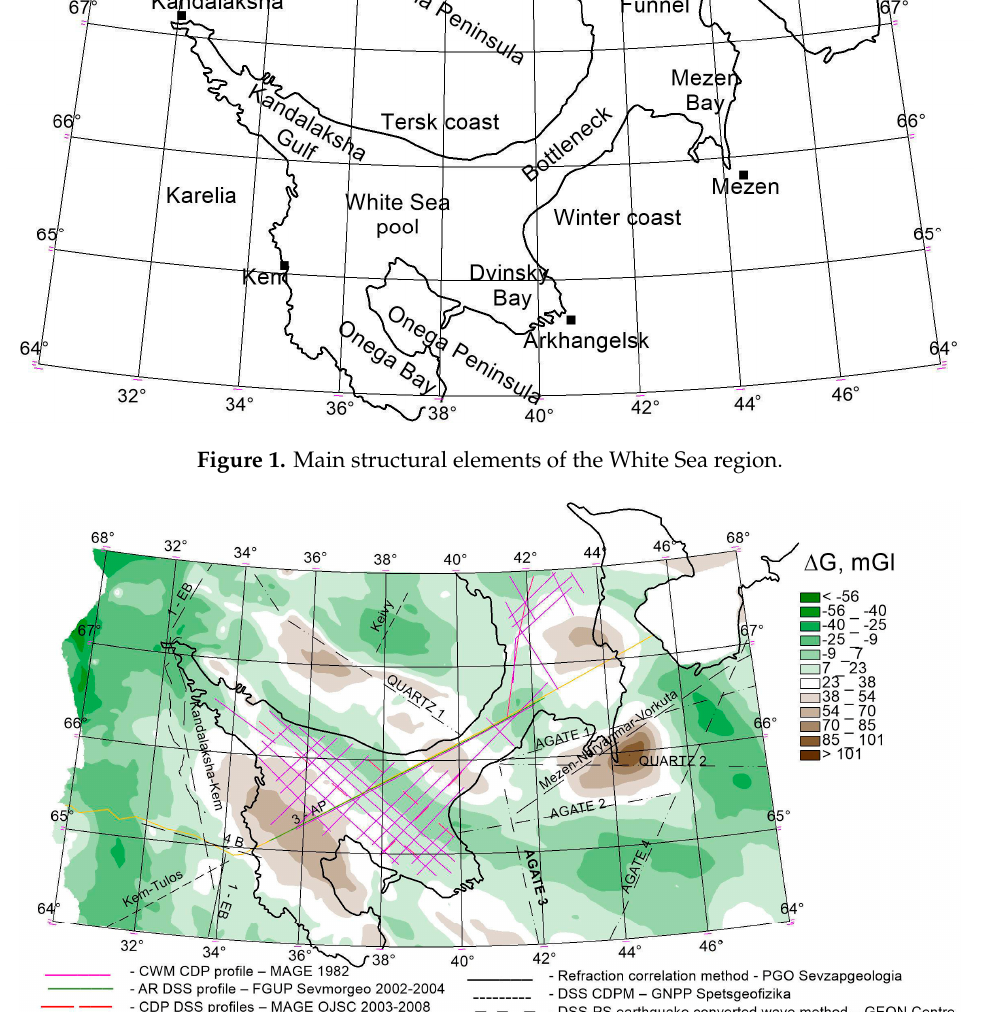
Figure 2. The layout of seismic profiles and the regional component of the gravity field in the Bouger reduction in the White Sea and adjacent reduction in the White Sea and adjacent territories.